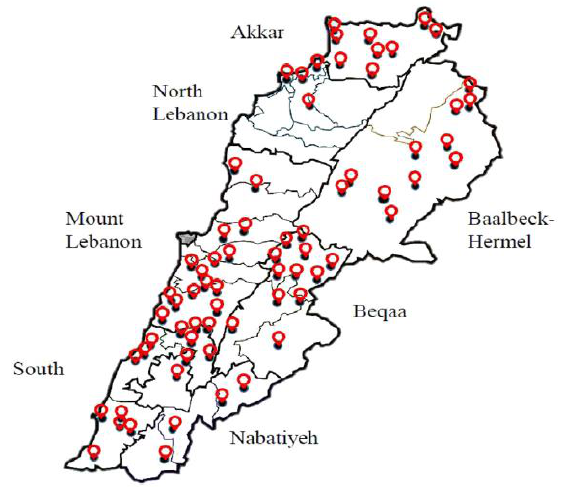
Figure 1. Sampling points of raw milk across Lebanon. Table 1. Collection date, number of samples collected, and farm characteristics across the different Lebanese governorates from which the samples were taken.